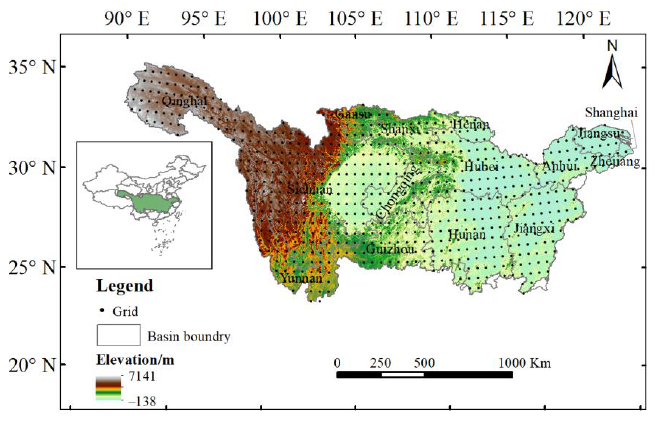
Figure 1. Topology and selected grids (0.5° × 0.5°) of the